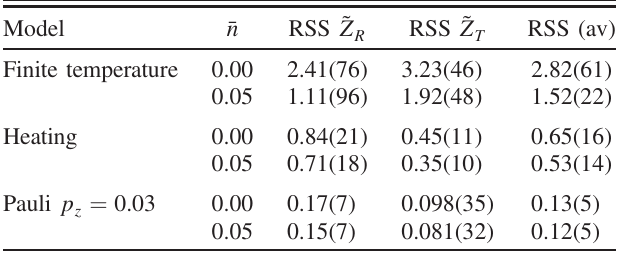
TABLE I. Comparison of the RSS obtained for the “ best fit ” of the considered error models. We show the values obtained for ˜ Z and T as well as their average for different mean phonon numbers ¯ n of the initial state.